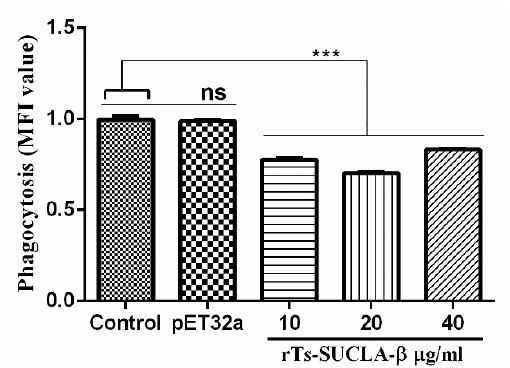
Figure 6. E ff ect of rTs-SUCLA- β on monocyte phagocytic activity in PBMCs treated with control (PBS), purified pET-32a protein and serial concentrations of rTs-SUCLA- β for 48 h, followed by incubating with Fluorescein Isothiocyanate (FITC)-dextran for 1 h. Phagocytic activity was tested based on FITC-dextran uptake by flow cytometry. Significant di ff erences were calculated from the standard error mean of three independent experiments and marked with *** when p < 0.001.